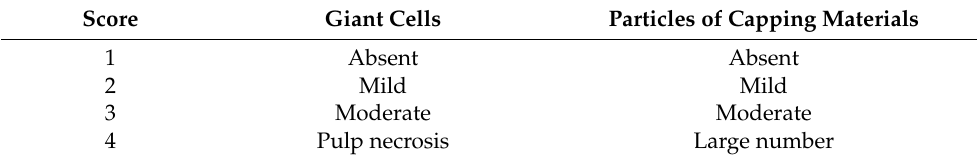
Table 4. Scores used for other pulpal